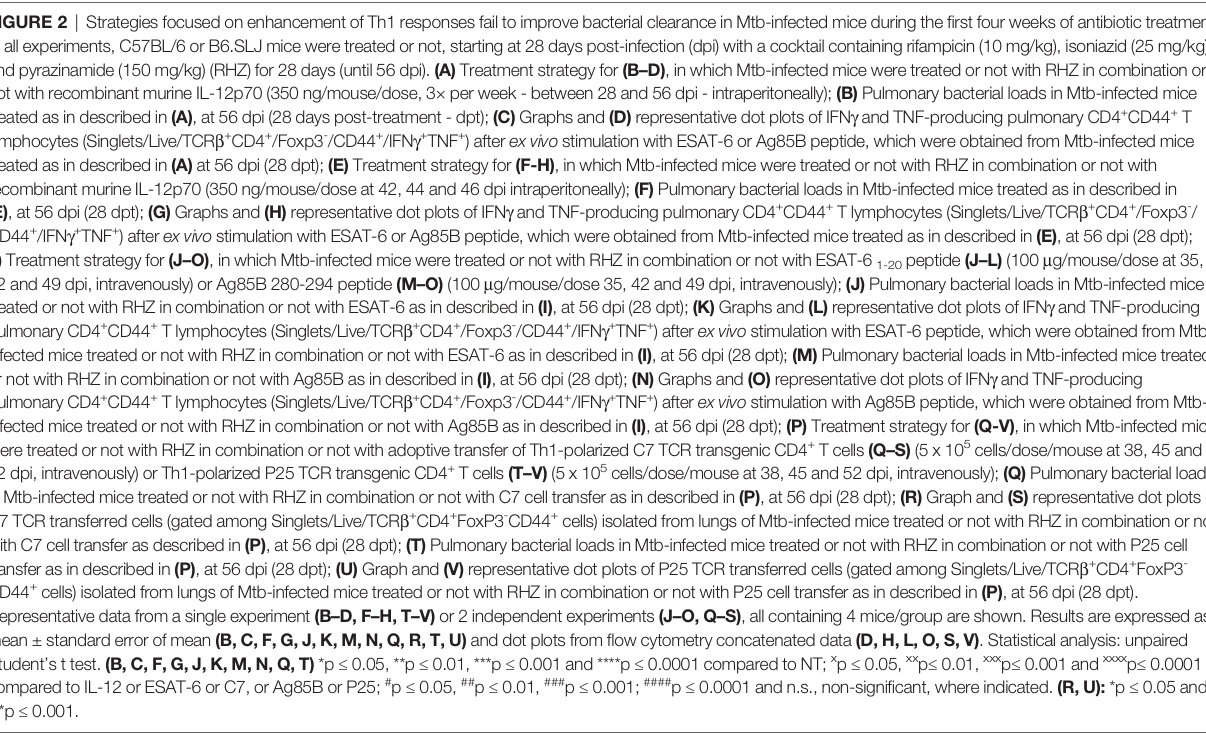
FIGURE 2 | Strategies focusedonenhancement of Th1responses failto improve bacterial clearance in Mtb-infected mice duringthe fi rst four weeks of antibiotictreatment. In allexperiments, C57BL/6 orB6.SLJ mice were treated or not, starting at28 dayspost-infection (dpi) with a cocktailcontainingrifampicin (10 mg/kg), isoniazid (25 mg/kg) and pyrazinamide (150 mg/kg)(RHZ)for 28 days(until56 dpi). (A) Treatment strategy for (B – D) , in which Mtb-infectedmice were treated ornot with RHZin combination or not with recombinant murine IL-12p70 (350 ng/mouse/dose, 3× per week - between 28 and 56 dpi - intraperitoneally); (B) Pulmonary bacterial loadsin Mtb-infected mice treated as in described in (A) , at56 dpi (28 dayspost-treatment - dpt); (C) Graphs and (D) representative dot plots of IFN g and TNF-producing pulmonary CD4 + CD44 + T lymphocytes (Singlets/Live/TCR b + CD4 + /Foxp3 - /CD44 + /IFN g + TNF + ) after ex vivo stimulation with ESAT-6 or Ag85B peptide, which were obtained from Mtb-infected mice treated as in described in (A) at 56 dpi (28 dpt); (E) Treatment strategy for (F-H) , in which Mtb-infectedmice were treated ornot with RHZin combination or not with recombinant murine IL-12p70 (350 ng/mouse/dose at 42, 44 and 46 dpi intraperitoneally); (F) Pulmonarybacterial loads inMtb-infectedmice treated as in described in (E) , at 56 dpi (28 dpt); (G) Graphs and (H) representative dot plots of IFN g and TNF-producing pulmonaryCD4 + CD44 + T lymphocytes (Singlets/Live/TCR b + CD4 + /Foxp3 - / CD44 + /IFN g + TNF + ) after ex vivo stimulation with ESAT-6 or Ag85B peptide, which were obtained from Mtb-infected mice treatedas indescribed in (E) , at 56 dpi (28 dpt); (I) Treatment strategyfor (J – O) , inwhich Mtb-infected mice were treated or not with RHZ incombination or not with ESAT-6 1-20 peptide (J – L) (100 m g/mouse/dose at 35, 42 and 49 dpi,intravenously) or Ag85B 280-294 peptide (M – O) (100 m g/mouse/dose 35, 42 and 49 dpi, intravenously); (J) Pulmonary bacterial loads inMtb-infectedmice treated or not with RHZ incombination or not with ESAT-6 as in described in (I) , at 56 dpi (28 dpt); (K) Graphs and (L) representative dot plots of IFN g and TNF-producing pulmonary CD4 + CD44 + T lymphocytes (Singlets/Live/TCR b + CD4 + /Foxp3 - /CD44 + /IFN g + TNF + ) after ex vivo stimulation with ESAT-6 peptide, which were obtained fromMtb- infected mice treated ornot with RHZin combination or not with ESAT-6 as in describedin (I) , at 56 dpi (28 dpt); (M) Pulmonary bacterial loadsin Mtb-infected mice treated or not with RHZ incombination ornot with Ag85B as indescribed in (I) , at 56 dpi (28 dpt); (N) Graphs and (O) representative dot plots of IFN g and TNF-producing pulmonary CD4 + CD44 + T lymphocytes (Singlets/Live/TCR b + CD4 + /Foxp3 - /CD44 + /IFN g + TNF + ) after ex vivo stimulation with Ag85B peptide, which were obtained fromMtb- infected mice treated ornot with RHZin combination or not with Ag85B as in describedin (I) , at 56 dpi (28 dpt); (P) Treatment strategyfor (Q-V) , in which Mtb-infected mice were treatedornot with RHZ in combination ornot with adoptive transfer of Th1-polarizedC7 TCR transgenic CD4 + T cells (Q – S) (5x 10 5 cells/dose/mouse at 38, 45